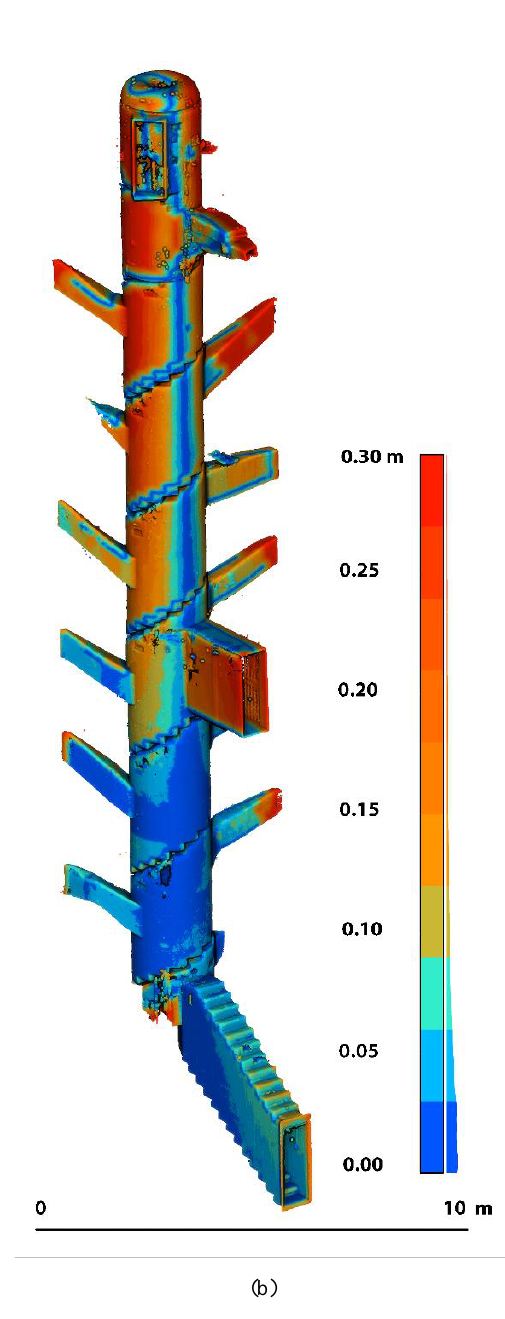
Figure 6 . (a) Ground truth and spatial map comparison. (b) Ground truth with color-coded deviations from spatial